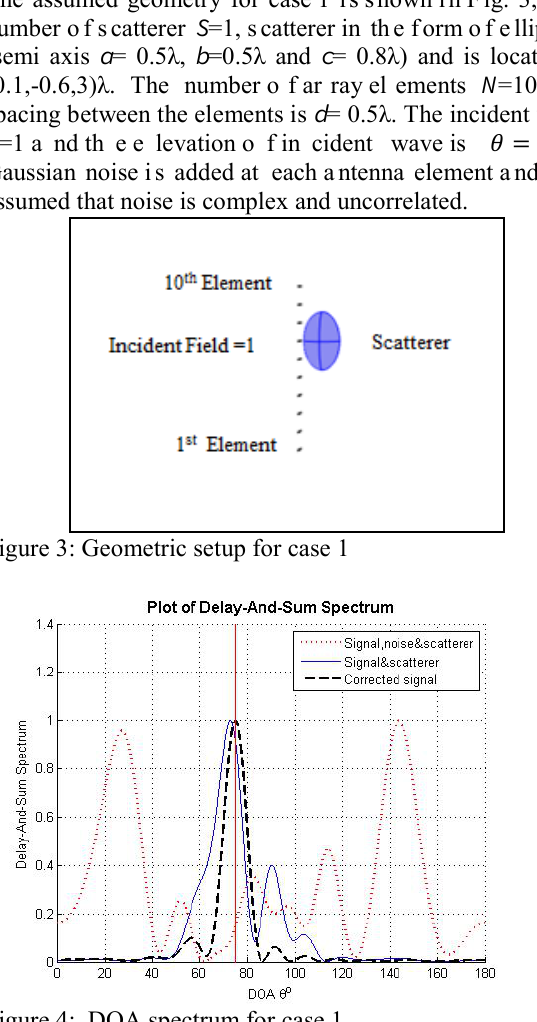
Figure 4: DOA spectrum for case